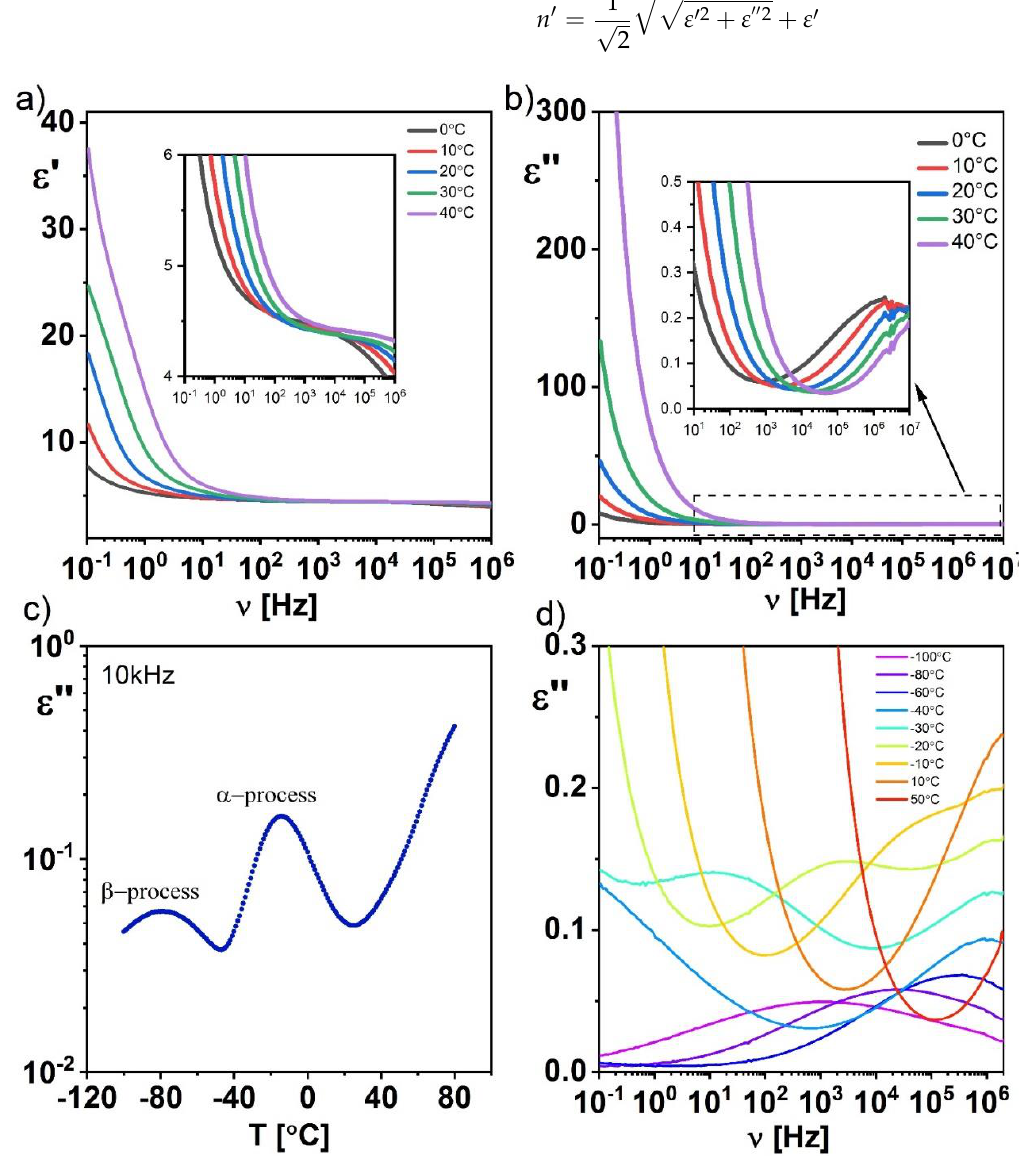
Figure 10 . Temperature evolution of the dielectric dispersion ( a ) and absorption ( b ) as well as the dielectric absorption at 10 kHz ( c ) and for chosen temperatures ( d ) for the pure Ecoflex ® layer.